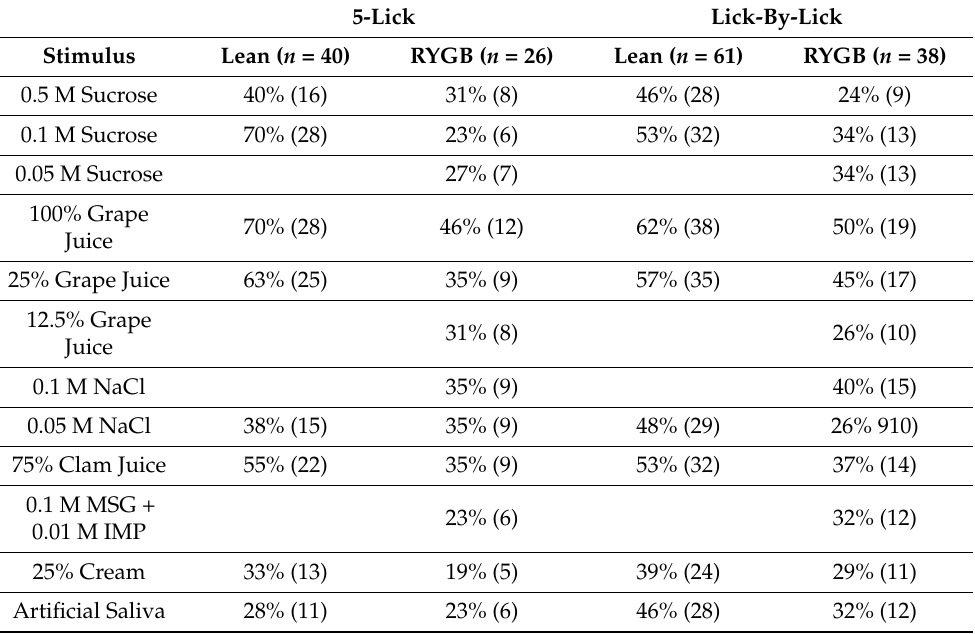
Figure 2. Examples of NTS responses in RYGB rats that occur in two time scales. In both ( A , B ), the top of each panel shows a raster of the firing of the cell. Each row represents one trial. Black dots indicate a spike and colored dots indicate reinforced licks. Light blue dots show licks to artificial saliva. ( A ) shows taste response that occurred over all five licks of a taste trial. ( B ) shows taste responses that occurred lick-by-lick. Note the comparisons with artificial saliva ( A , B) and with dry licks ( B ). Table 1. Percent taste responses (number) in Lean and RYGB